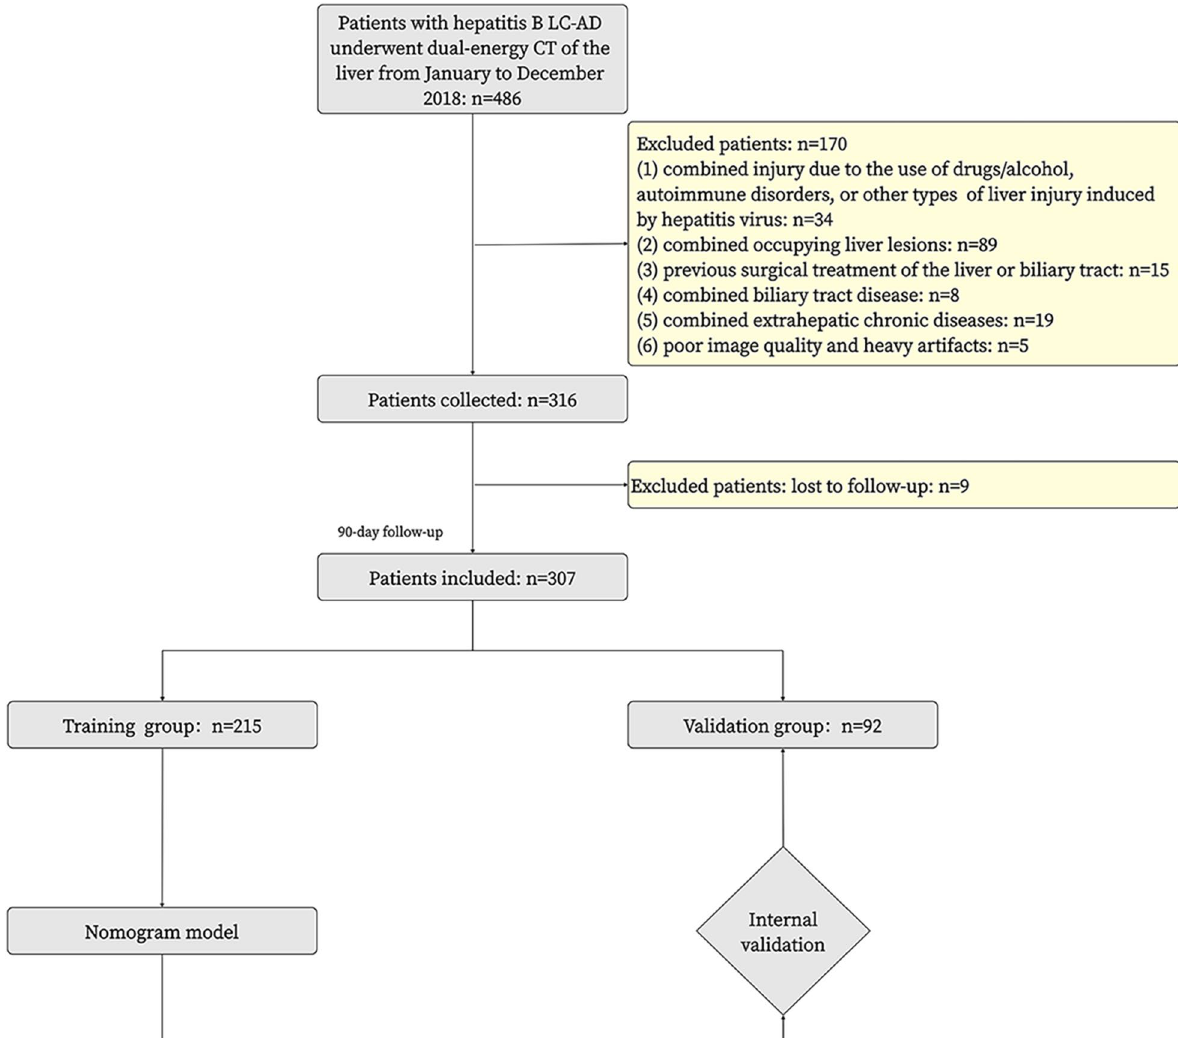
Fig. 1 Flowchart of patient selection. LC-AD, liver cirrhosis-acute decompensation; ACLF, acute-on-chronic liver